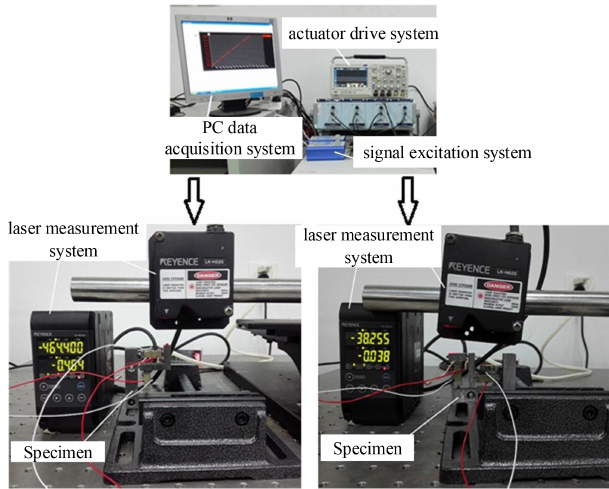
Figure 13. Diagram of experimental measurement system.